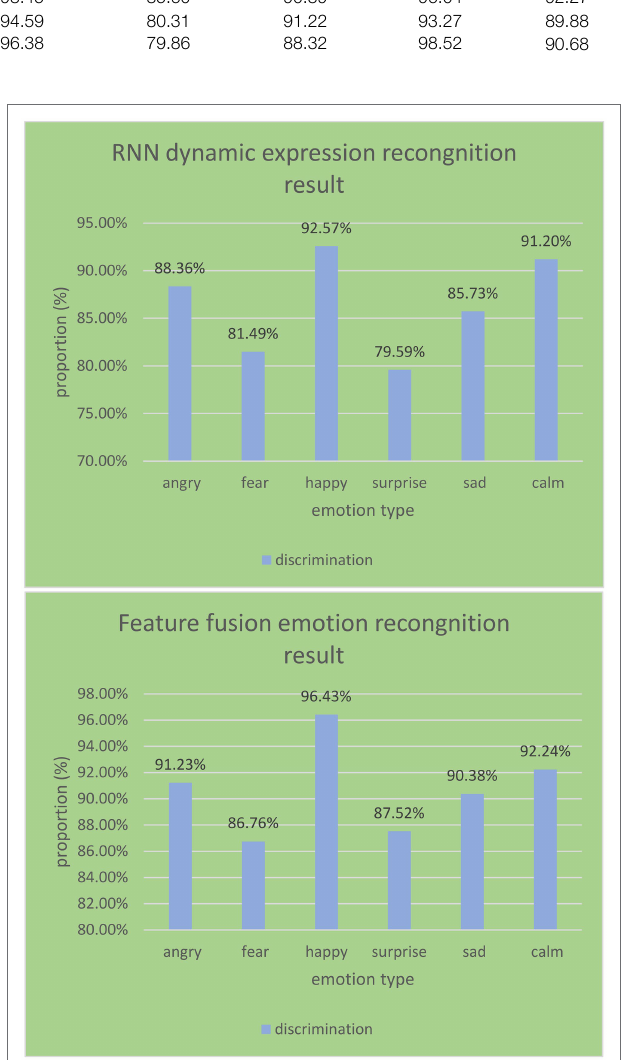
FIGURE 12 | RNN emotion recognition results and feature fusion recognition results.